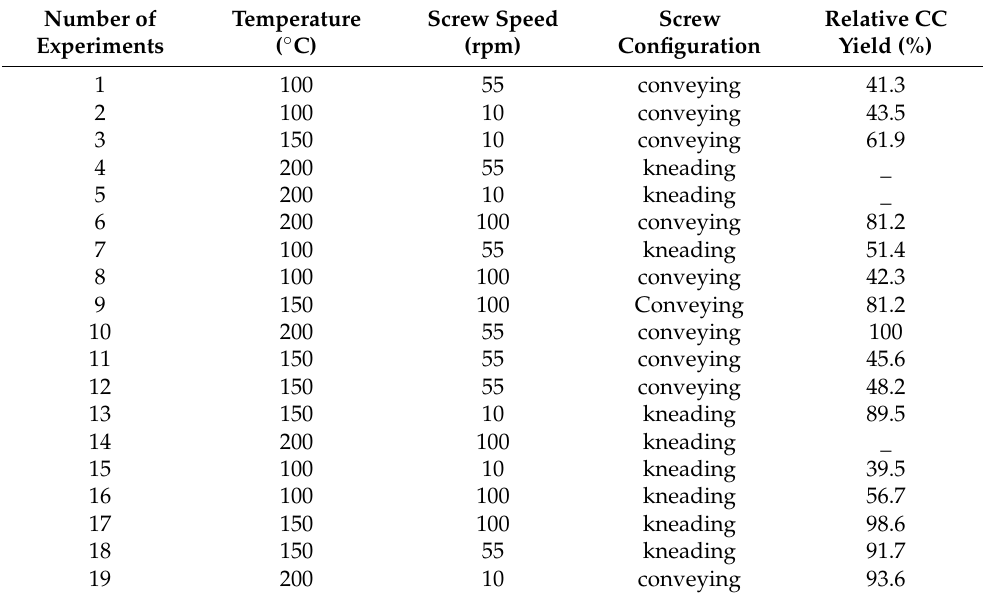
Table 1. Factorial design of experiment and the considered parameters to be studied with their corresponding values. Number of Experiments